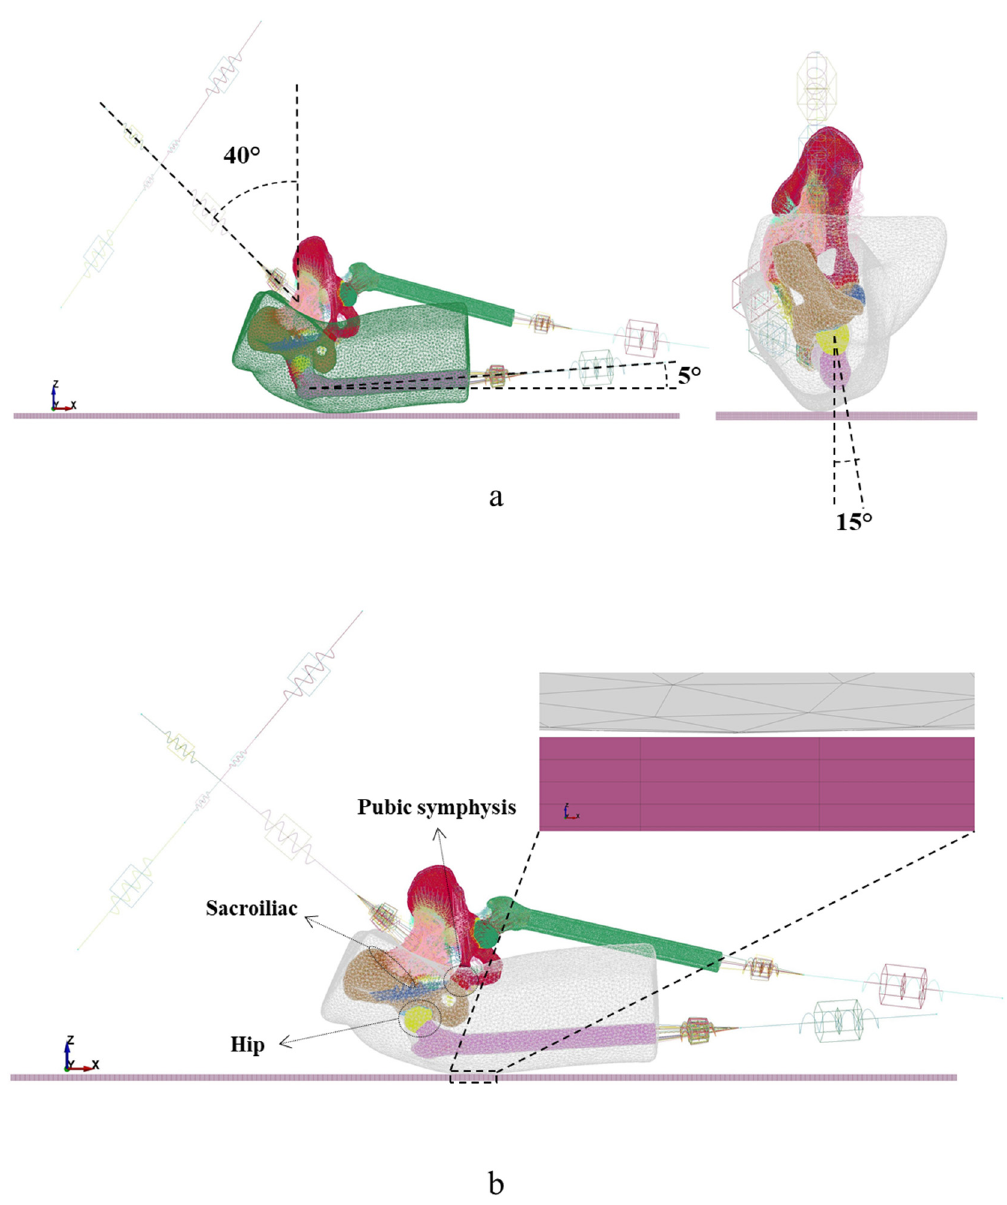
Figure 1. ( a ) Body configuration angles at the impact; ( b ) location of the joints and the initial position of the model relative to the ground.